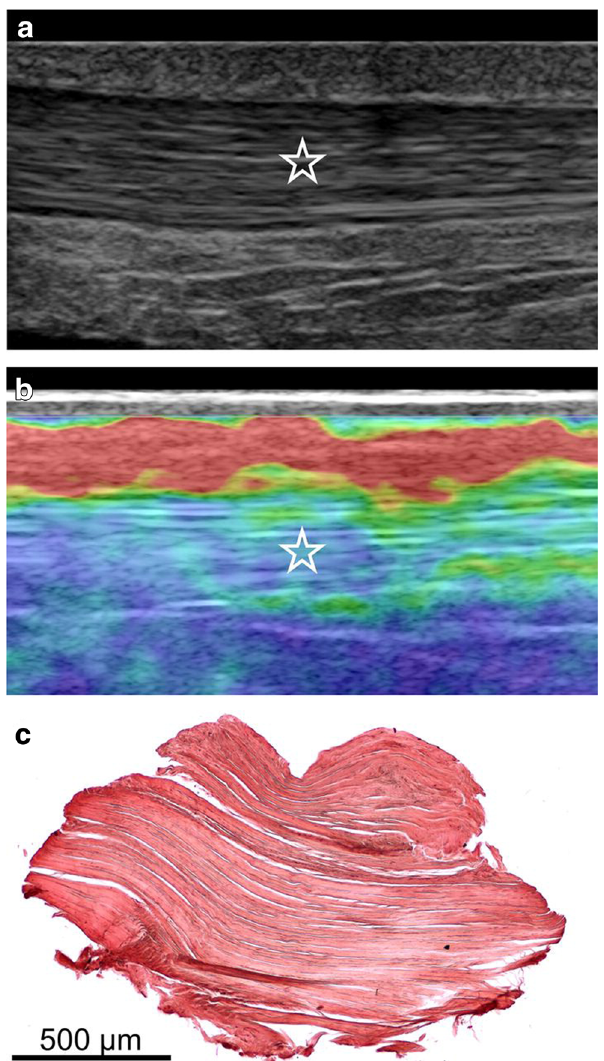
Fig. 4 Images of an Achilles tendon with tendinopathy using CE and histological correlation. a Conventional US image of the insertion of the Achilles tendon in the longitudinal plane. The asterisks indicate the hypoechoic area without tendon thickening. CAL: calcaneus. b Image of USE at the same level as a . The red area of the elastogram represented by asterisks is indicative of anomalous decrease of stiffness where biopsy was subsequently performed. c Histological image obtained with azan staining showing loss of the parallel fibrillar structure of the collagen, loss of fibre integrity (asterisks), adipose infiltration (circles), capillary proliferation (plus) and mucoid deposition (star). Reproduced, with permission, from Klauser et al. [31], copyright (2013) by the Radiological Society of North America, Inc.